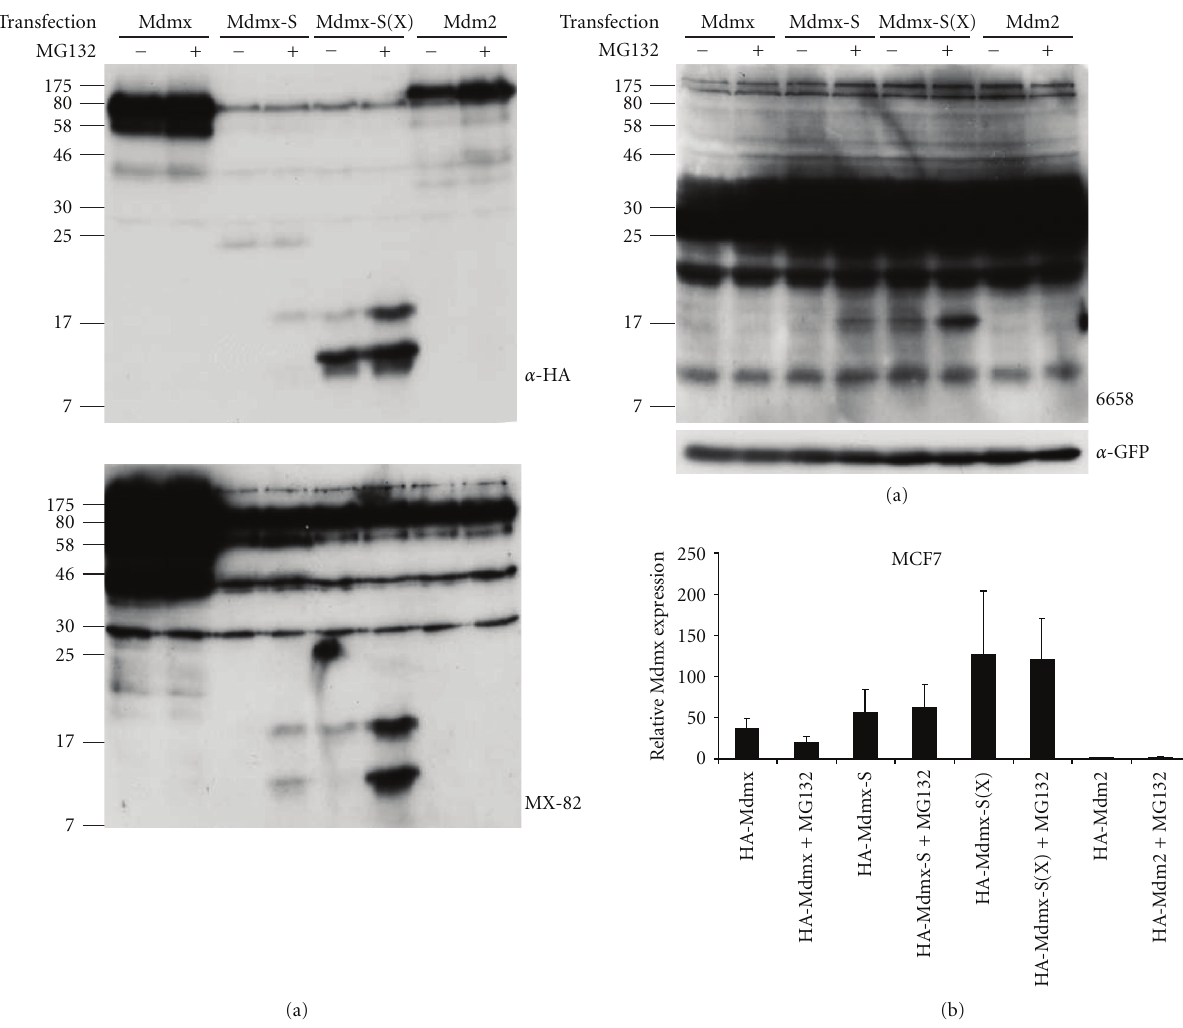
Figure 4: Expression of Mdmx-S protein is much lower compared to full-length Mdmx and increased upon MG132 treatment, whereas mRNA levels are even higher in transfection studies. MCF7 cells were transfected with the indicated constructs (6-well plates; 1 μ g of each construct/well; all well were also transfected with 250ng of CMV-eGFP expression vector as transfection control). Twenty four hrs after transfection, the cells were either mock treated or treated with 20 μ M MG132 for 7 hours. Cell lysates were analyzed by Western Blotting with the indicated antibodies (6658 = MDMX-S specific antibody) and extracted RNA was analyzed by quantitative real-time